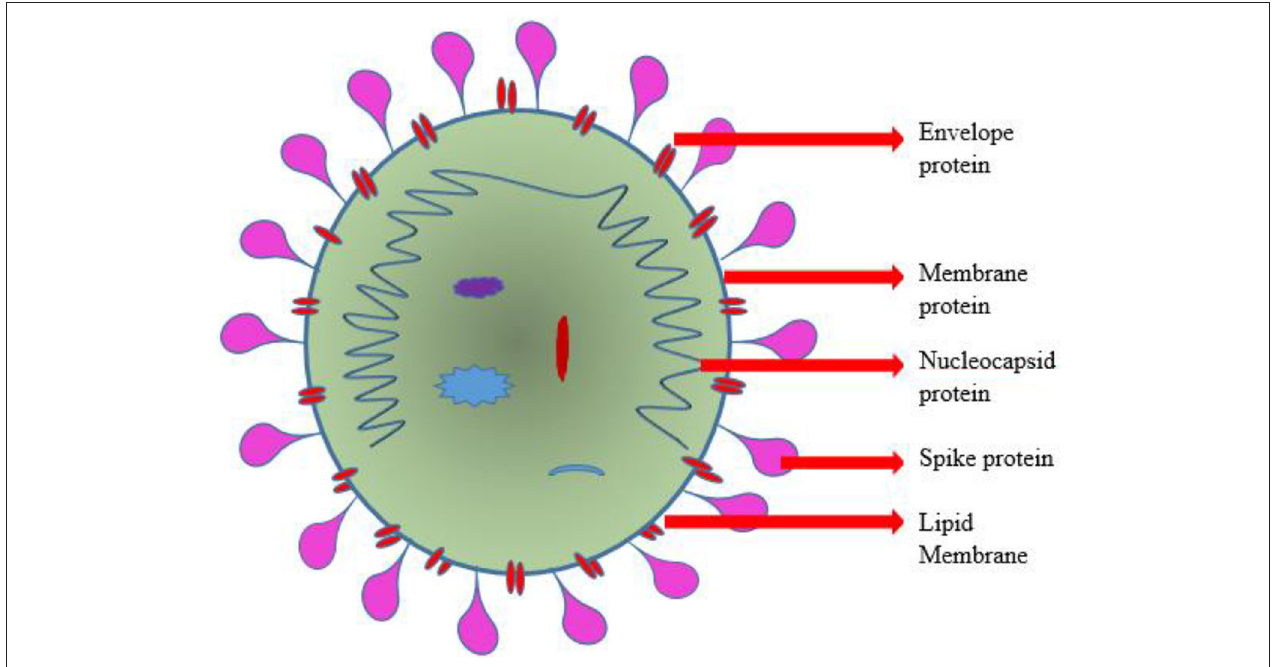
FIGURE 1 | Schematic representation of the structure of coronavirus